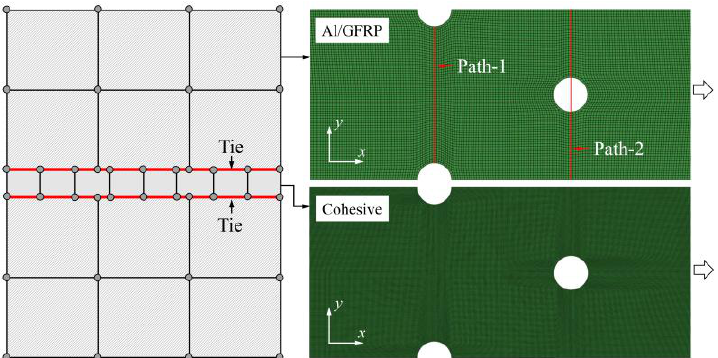
Figure 5. Mesh strategy and mesh refinements in vicinities of the holes (H3R2S specimen is an example; Path-1 and Path-2 were defined for stress distribution analyses).